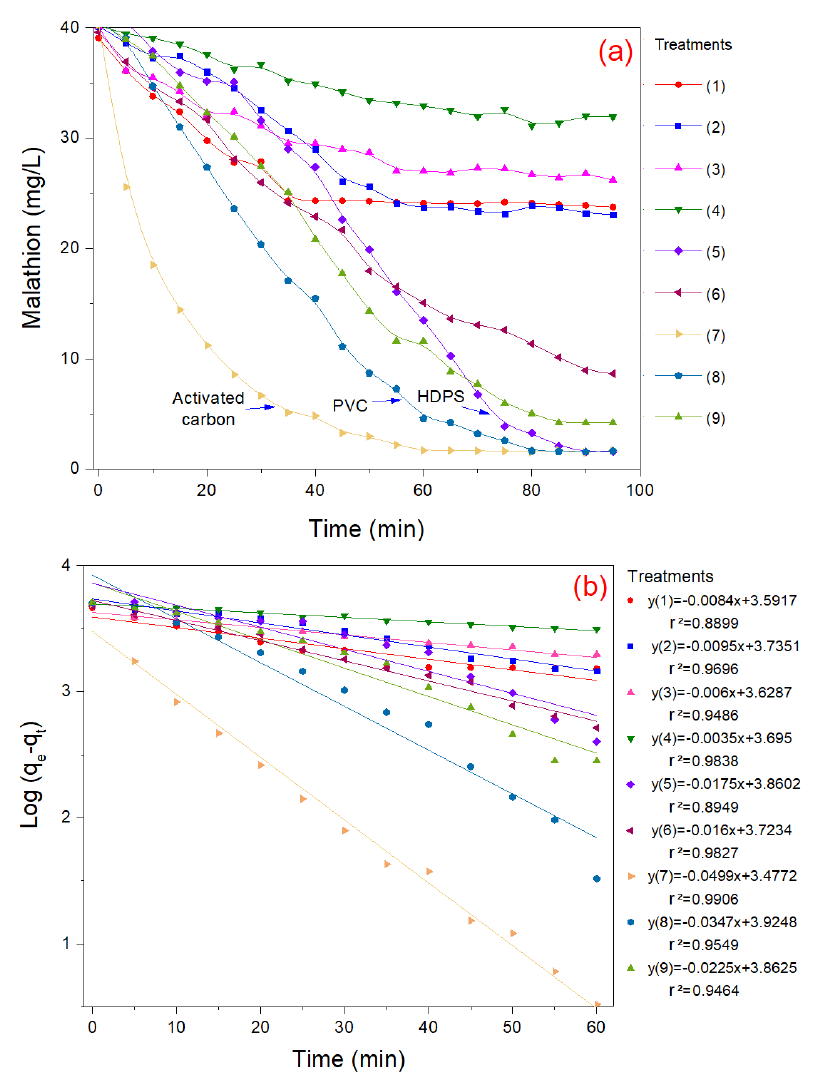
Figure 1. Behavior of malation adsorption process under different conditions ( a ) and its kinetic modeling ( b